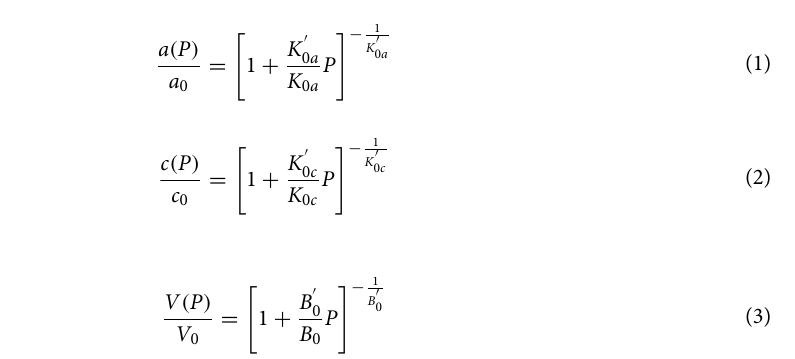
Figure 3. (a–c) Pressure dependence of normalized lattice parameters of the sub-free SDD-GaSe film and GaSe bulk, in comparison to the reproduced data with permission from Ref. 29 . (d) Inverted Birch-Murnaghan EoS fitting of the sub-free SDD-GaSe film. (e) Unit-cell volume of the sub-free SDD-GaSe film as a function of pressure revealing a transition region (20–25 GPa) from hexagonal to high-pressure rock-salt